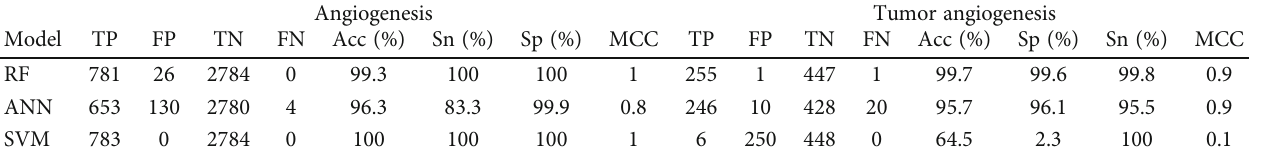
Table 4: Jackknife